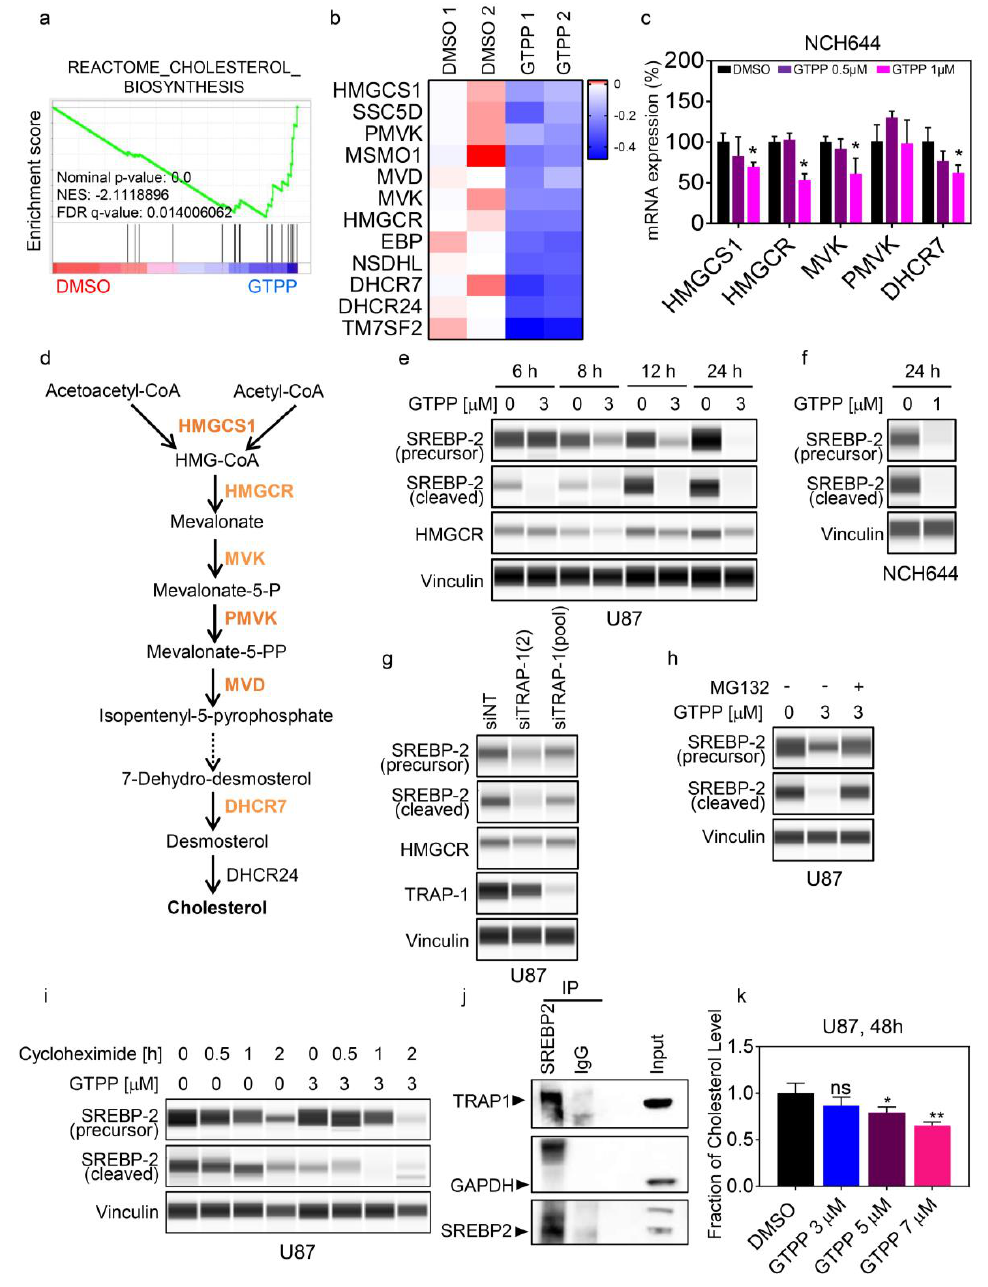
Figure 1. Tumor Necrosis Factor Receptor-associated Protein 1 (TRAP1) regulates cholesterol biosynthesis. ( a ) NCH644 cells were treated with 1 µM gamitrinib (GTPP) for 24 hours. Transcriptome and gene set enrichment analysis was performed. Shown is an enrichment plot. NES: